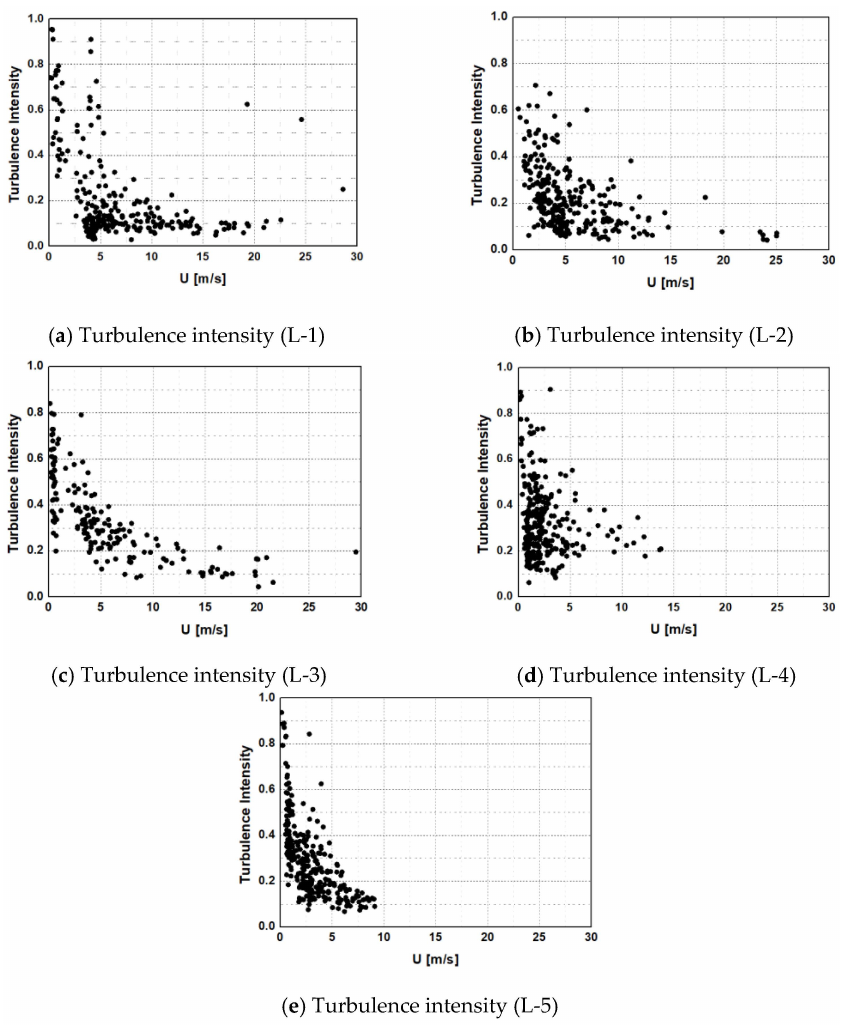
Figure 14. Variations in the turbulence intensity with the mean speed for ( a – e ) L-1 to L-5,